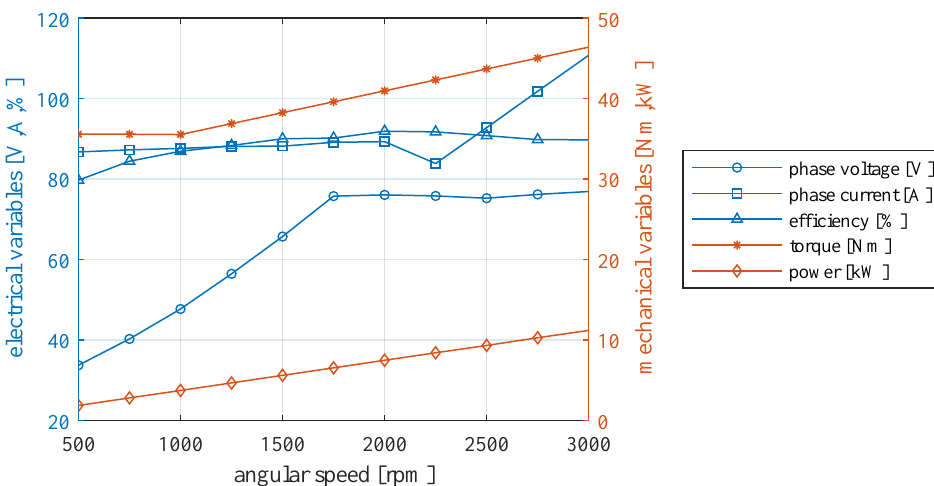
Figure 3. Induction electric motor characteristic